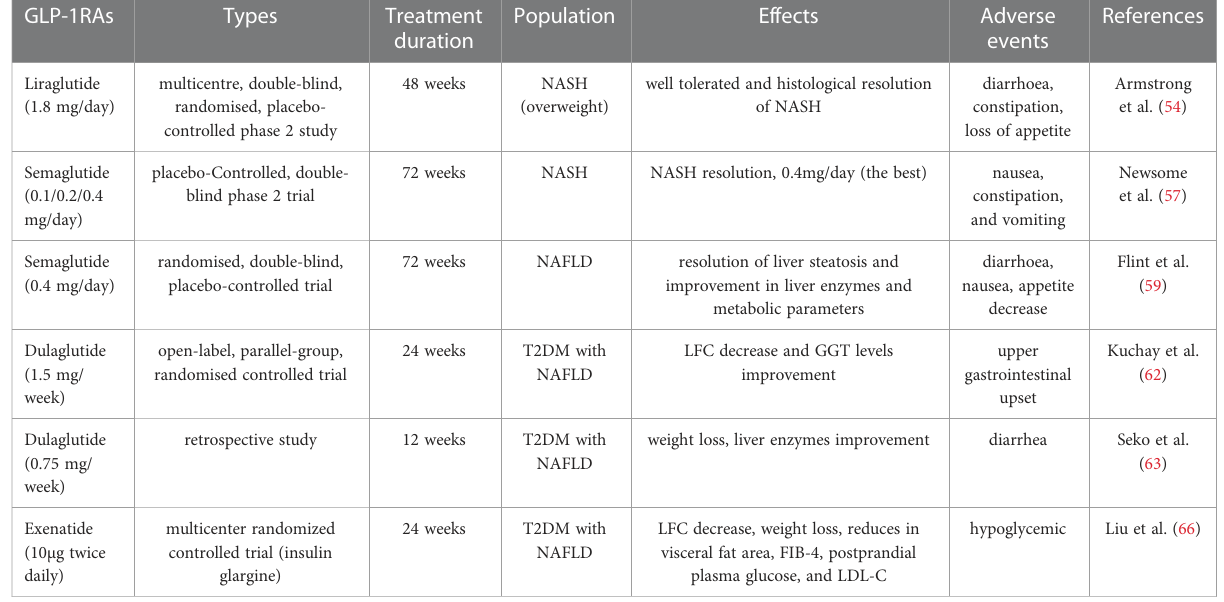
TABLE 1 Effect of GLP-1RAs in patients of NAFLD/NASH: Data from clinical studies.